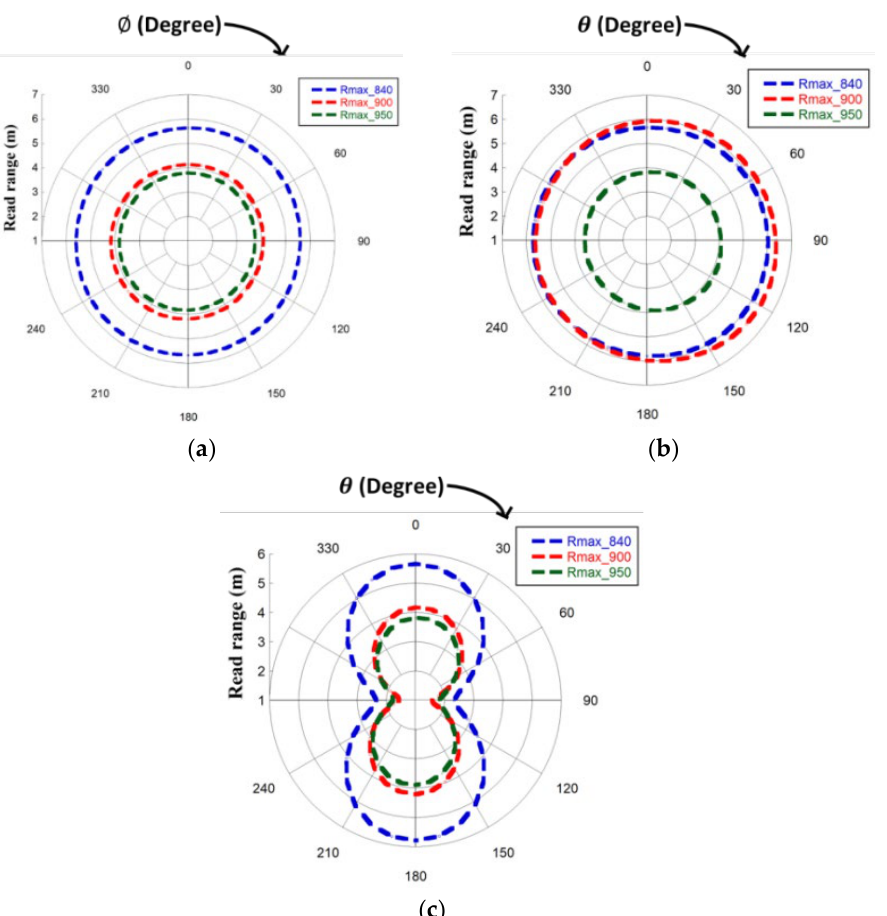
Figure 12. Measured Read range for three frequencies (840 MHz, 900 MHz, and 950 MHz) at ( a ) XY , ( b ) XZ, and ( c ) YZ planes .